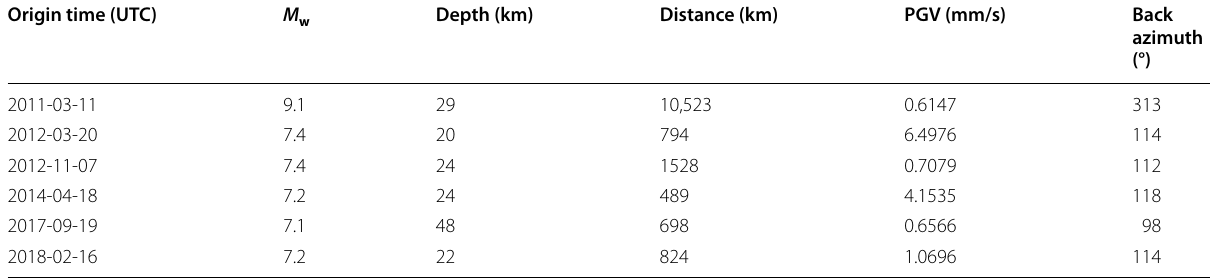
Table 3 PGV of other teleseismic earthquakes recorded at CJIG from 2011 to 2019 Origin time